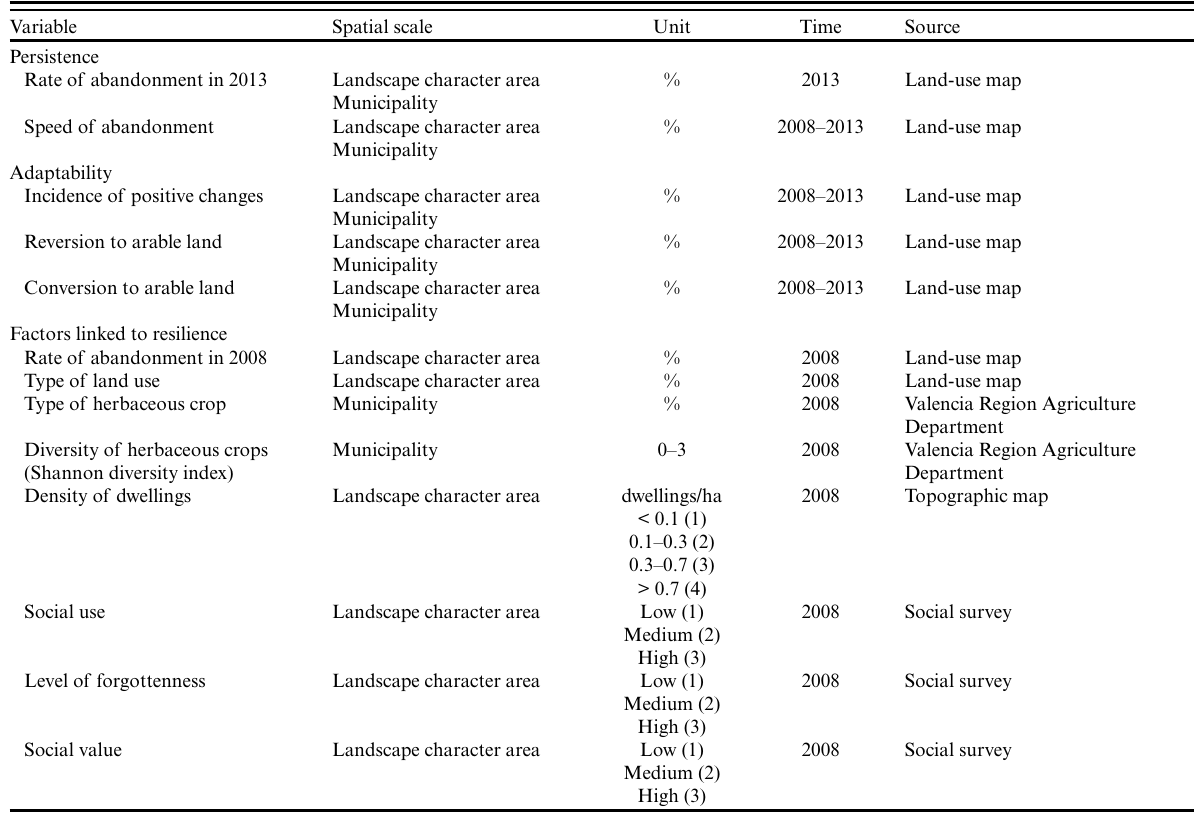
Table 1. List of variables linked to resilience that were included in the